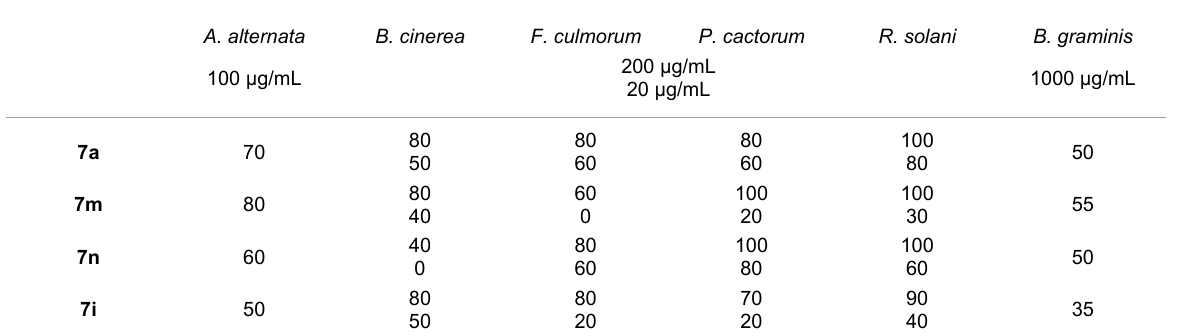
Table 4: Fungicidal activity of the active compounds a